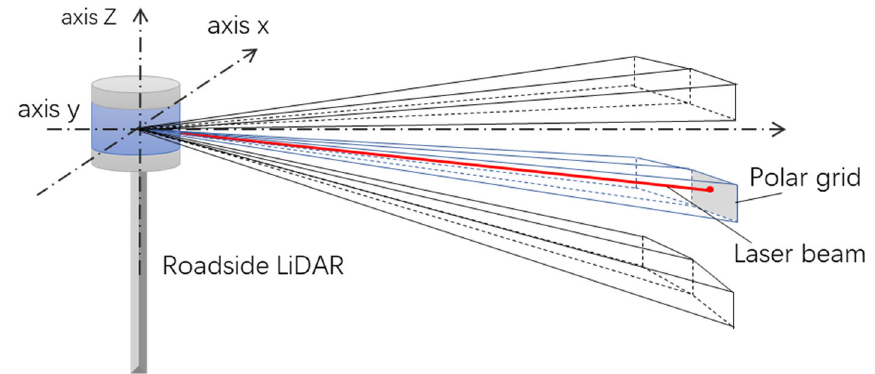
Figure 6. Schematic diagram of a polar grid.